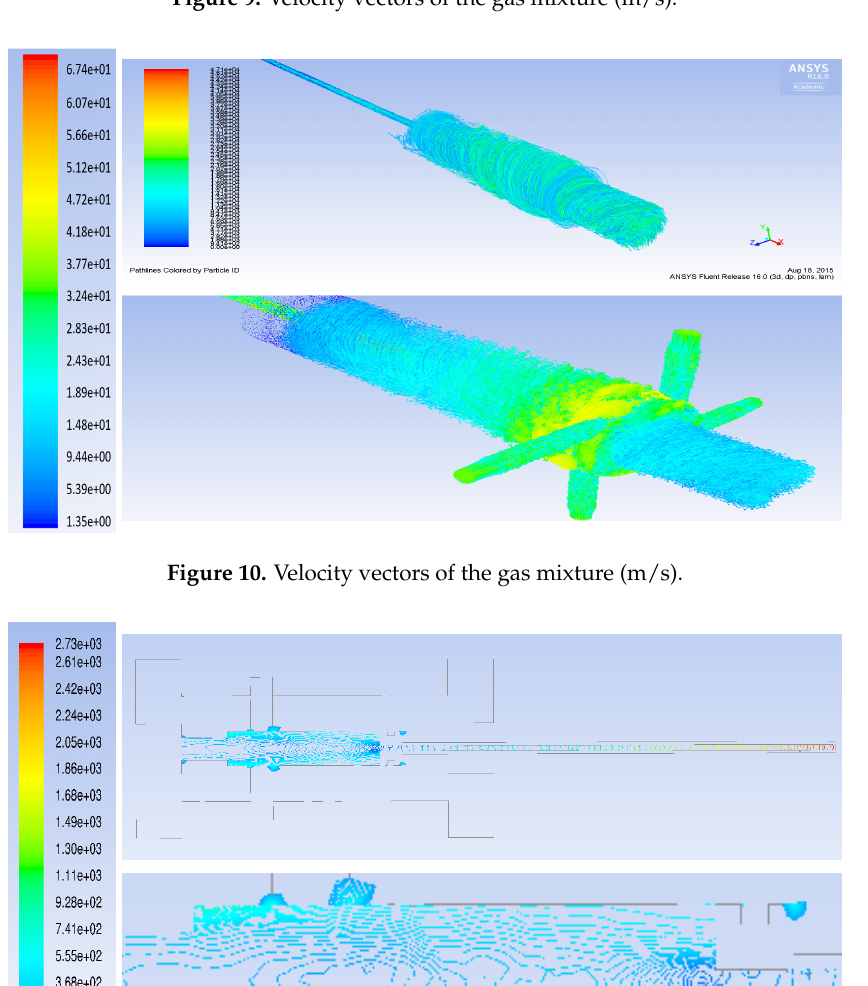
Figure 9. Velocity vectors of the gas mixture (m/s).